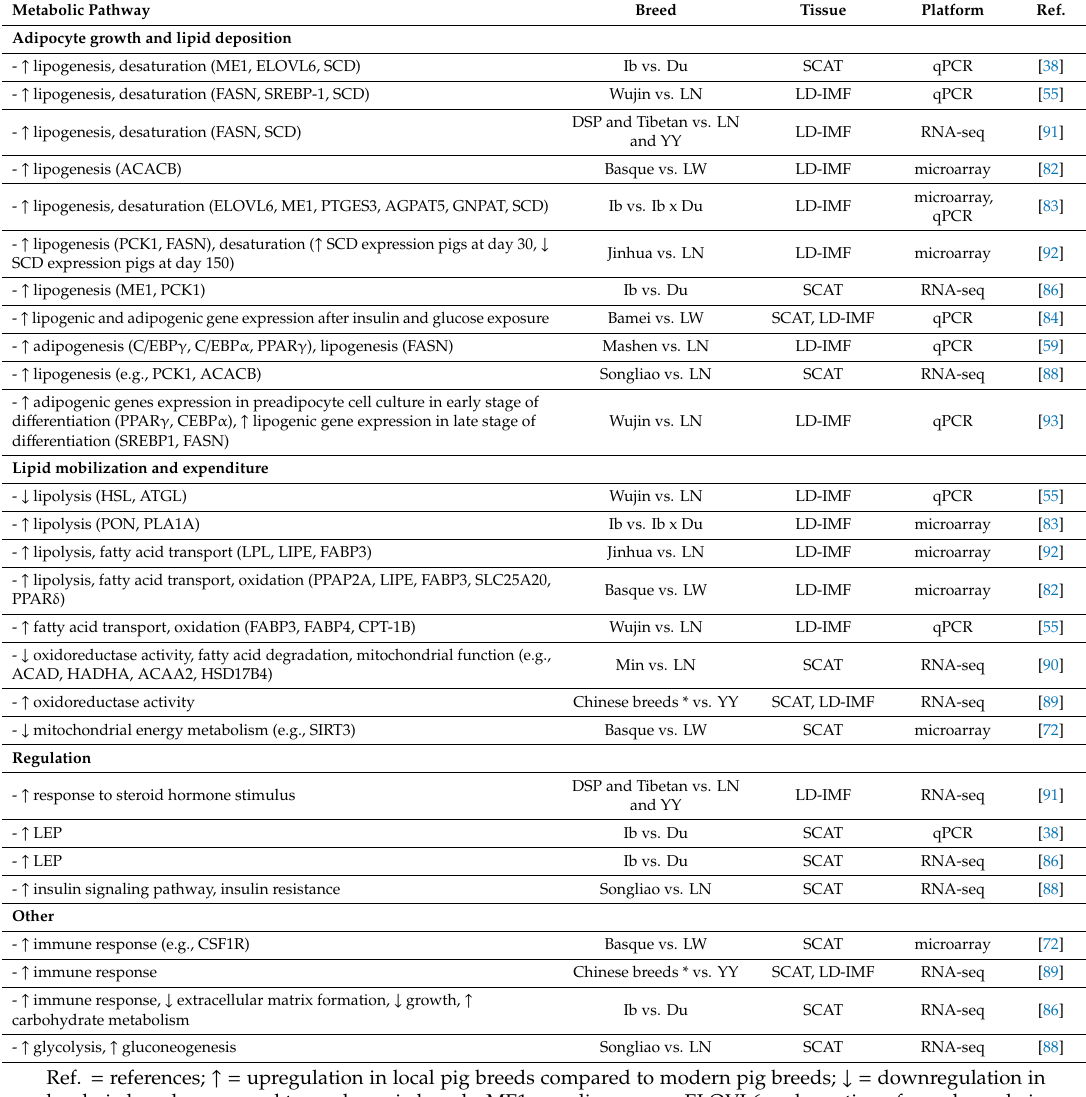
Table 4. Summary of comparative transcriptomic studies with the main findings between local and modern pig breeds associated with fat deposition. Metabolic Pathway Breed Tissue Platform Ref.